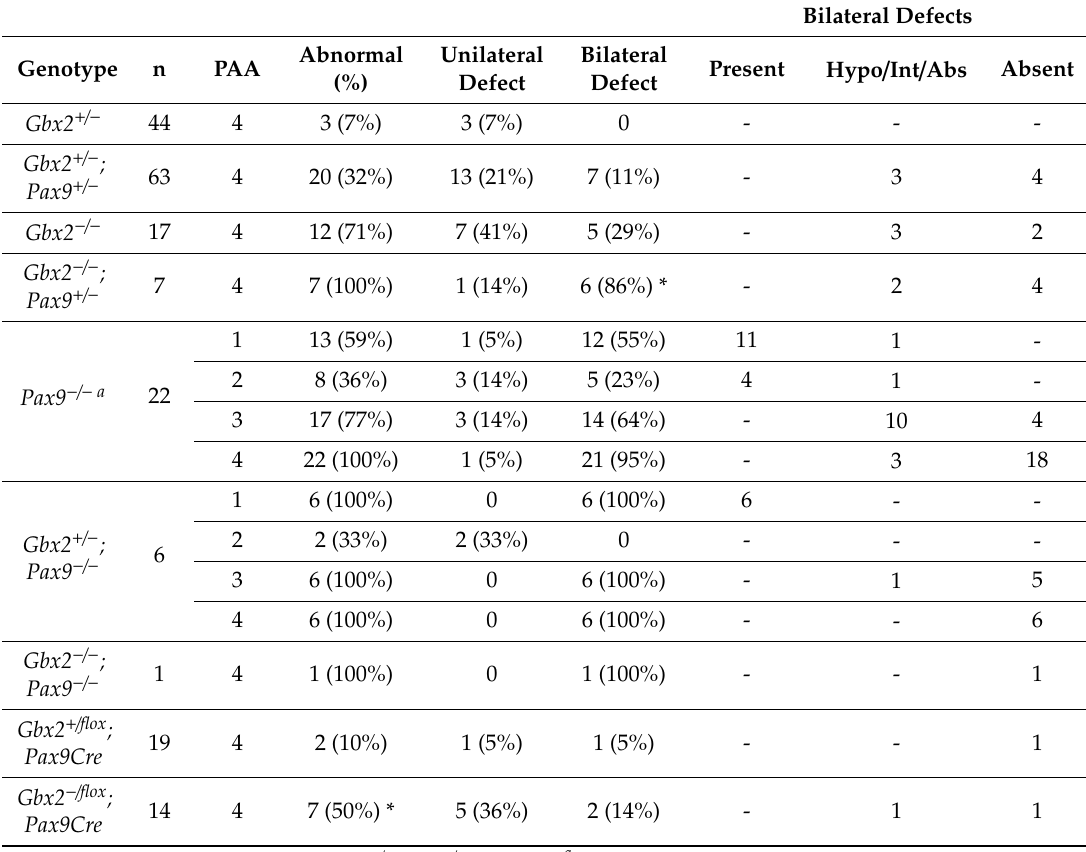
Table 2. Number of pharyngeal arch artery defects observed in Gbx2;Pax9 mutant embryos.